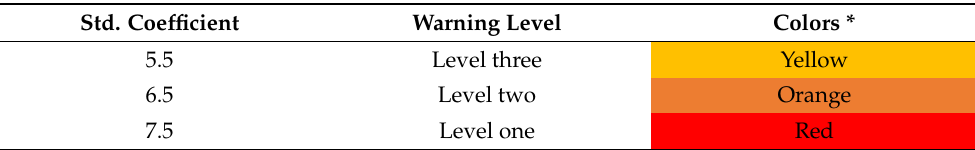
Figure 14. Anomaly proportion under different std. coefficients. Table 5. Warning level setting.